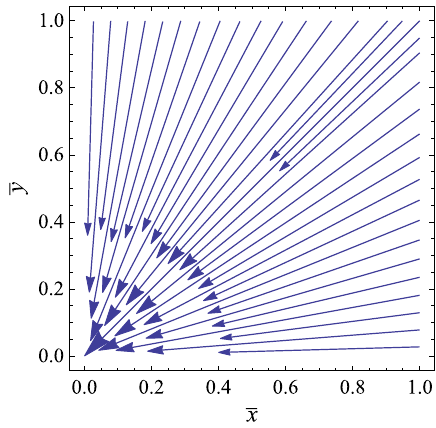
Fig. 5 Orbits of the phase space of system